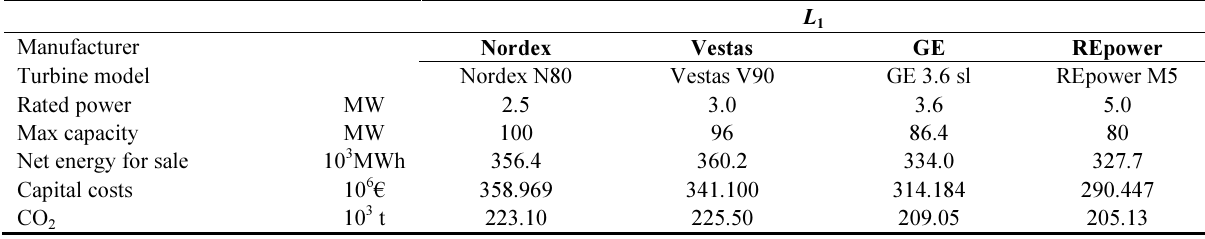
Table 3. L 2 alternative